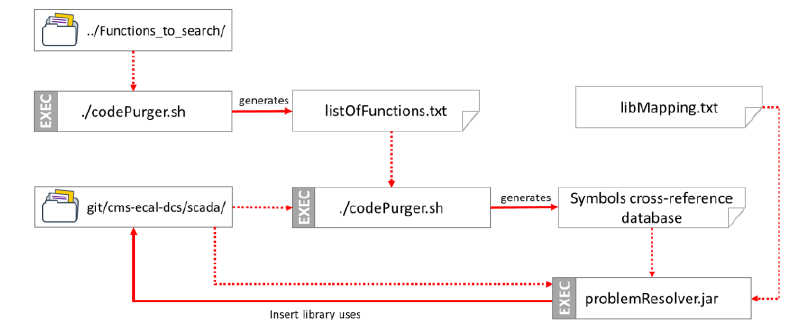
Fig. 2. Look up and automatic transformation process to include library uses.